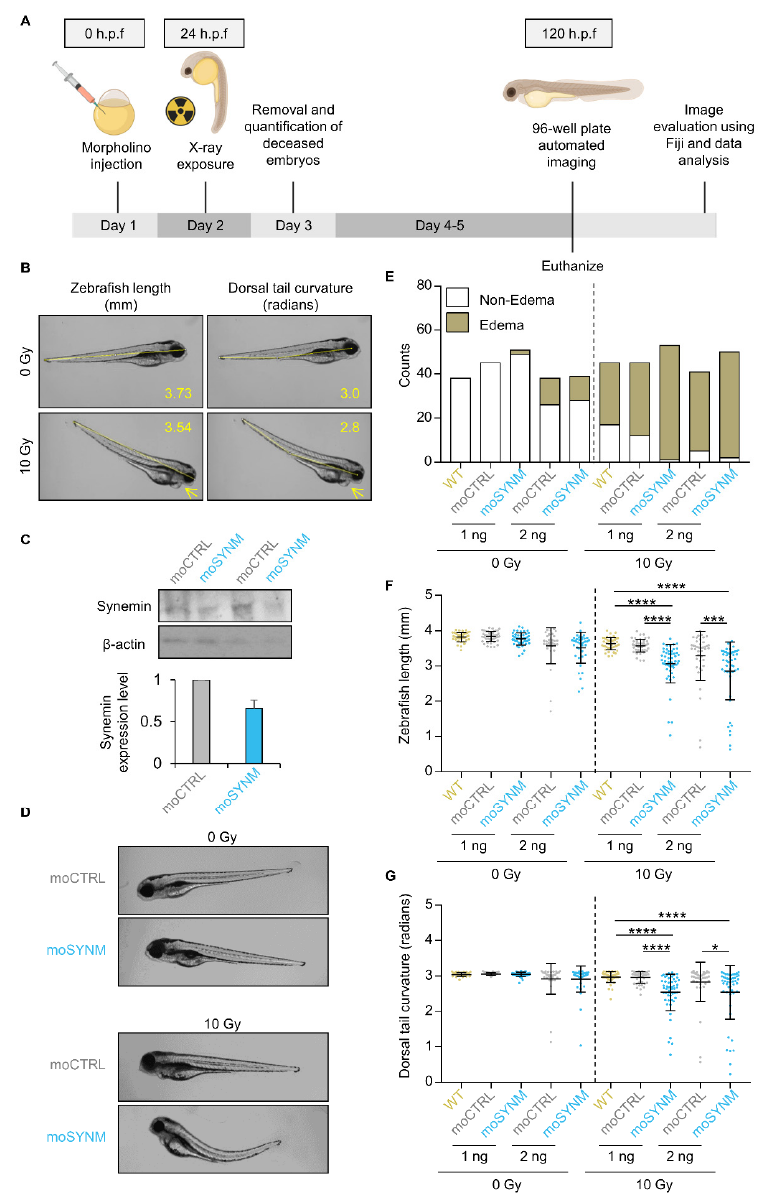
Figure 2. Targeting synemin elicits enhanced radiosensitivity in zebrafish. ( A ) Workflow of experimental set up. Immediately after fertilization (0 h post fertilization (h.p.f.), morpholinos were injected with di ff erent concentrations (1 or 2 ng). Scrambled non-specific control morpholino (moCTRL) or synemin-specific morpholino (moSYNM) were applied or zebrafish were left untransfected (wild type (WT)). Next day, the embryos were irradiated with 10 Gy X-ray. Zebrafish larvae were imaged for quantification of morphological changes and subsequently euthanized prior to 120 h.p.f. ( B ) Representative images of zebrafish larvae upon indicated treatment. Edema, length, and dorsal tail curvature were quantified using Fiji software. Numbers in yellow indicate the lengths measurements and the yellow arrows indicate edema. ( C ) Knockdown e ffi ciency after control and synemin-specific morpholino transfection in whole cell lysates from zebrafish. Representative Western blots and densitometries are shown. ( D ) Representative images of zebrafish larvae tail curvature upon indicated treatment. ( E ) Quantification of edema upon indicated treatments ( p -value, logistic regression analysis). ( F ) Quantification of zebrafish length and ( G ) dorsal tail curvature for indicated treatment conditions. Data are presented as mean ± SD ( n = 2; at least 15 embryos per trial were evaluated, N > 30; one-way ANOVA followed by post-hoc analysis using Tukey’s correction; * p < 0.05, *** p < 0.001, **** p <